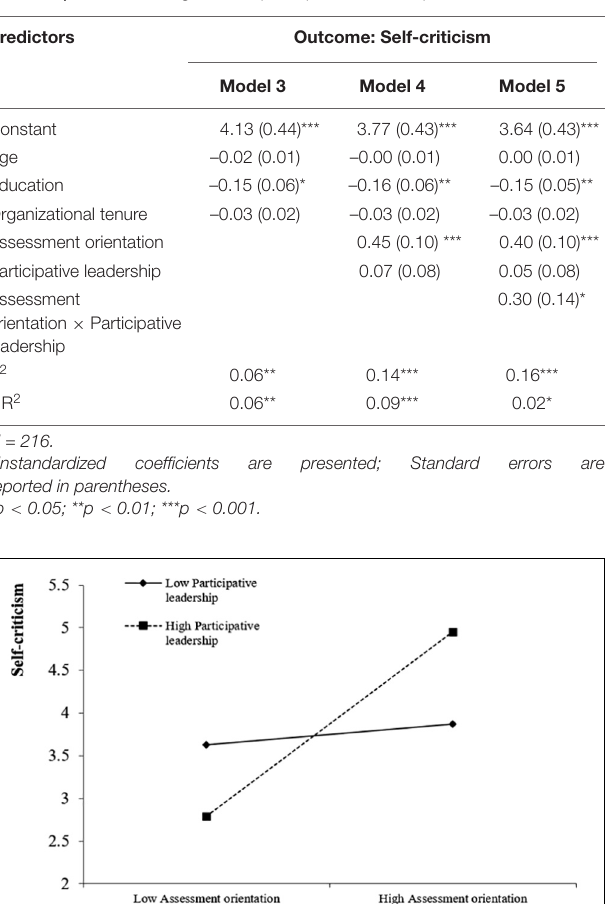
TABLE 5 | The moderating effect of participative leadership.